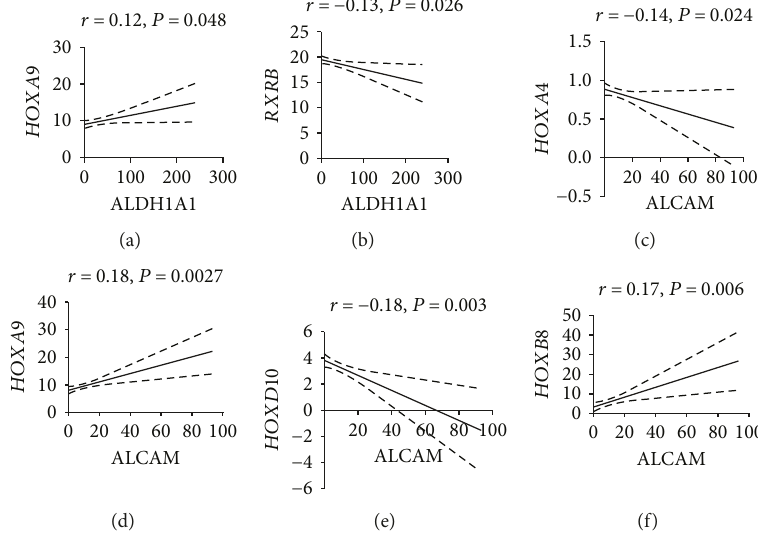
Figure 8: Correlation analysis of HOX genes and retinoid receptors with stem cell markers in colorectal cancer. (a) The expression of HOXA9 and ALDH1A1 (SC marker) in colorectal cancer (CRC) patients is correlated by Pearson correlation. A positive signi fi cant correlation was observed between HOXA9 and ALDH1A1 ( r = 0 12 , P = 0 048 ). (b) The expression of retinoid receptor RXRB and ALDH1A1 in CRC patients is correlated by Pearson correlation. A negative signi fi cant correlation was observed between RXRB and ALDH1A1 ( r = − 0 13 , P = 0 026 ). (c) The expression of HOXA4 and ALCAM (CD166, SC marker) in CRC patients correlated by Pearson correlation. A negative signi fi cant correlation was observed between HOXA4 and ALCAM ( r = − 0 14 , P = 0 024 ). (d) The expression of HOXA9 and ALCAM in CRC patients correlated by Pearson correlation. A positive signi fi cant correlation was observed between HOXA9 and ALCAM ( r = 0 18 , P = 0 0027 ). (e) The expression of HOXD10 and ALCAM in CRC patients correlated by Pearson correlation. A negative signi fi cant correlation was observed between HOXD10 and ALCAM ( r = − 0 18 , P = 0 003 ). (f) The expression of HOXB8 and ALCAM in CRC patients correlated by Pearson correlation. A positive signi fi cant correlation was observed between HOXB8 and ALCAM ( r = − 0 17 , P = 0 006 ).